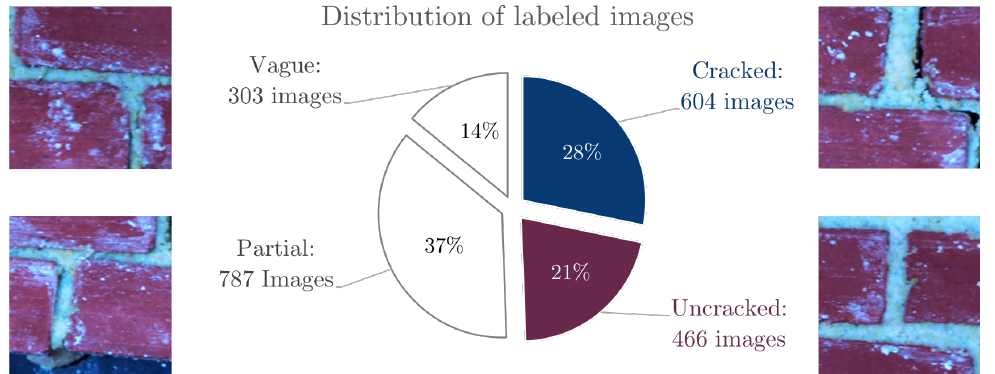
Figure 4. The distribution of images in the data set with representative